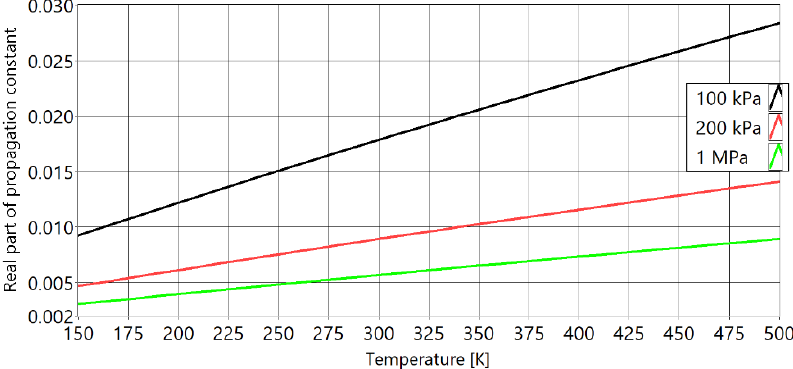
Figure 4. Real part of the propagation constant of the model for different values of pressure inside of PAT waveguides. With black is marked isobar of 100 kPa, with red is marked isobar of 400 kPa and with green is marked isobar of 1 MPa.